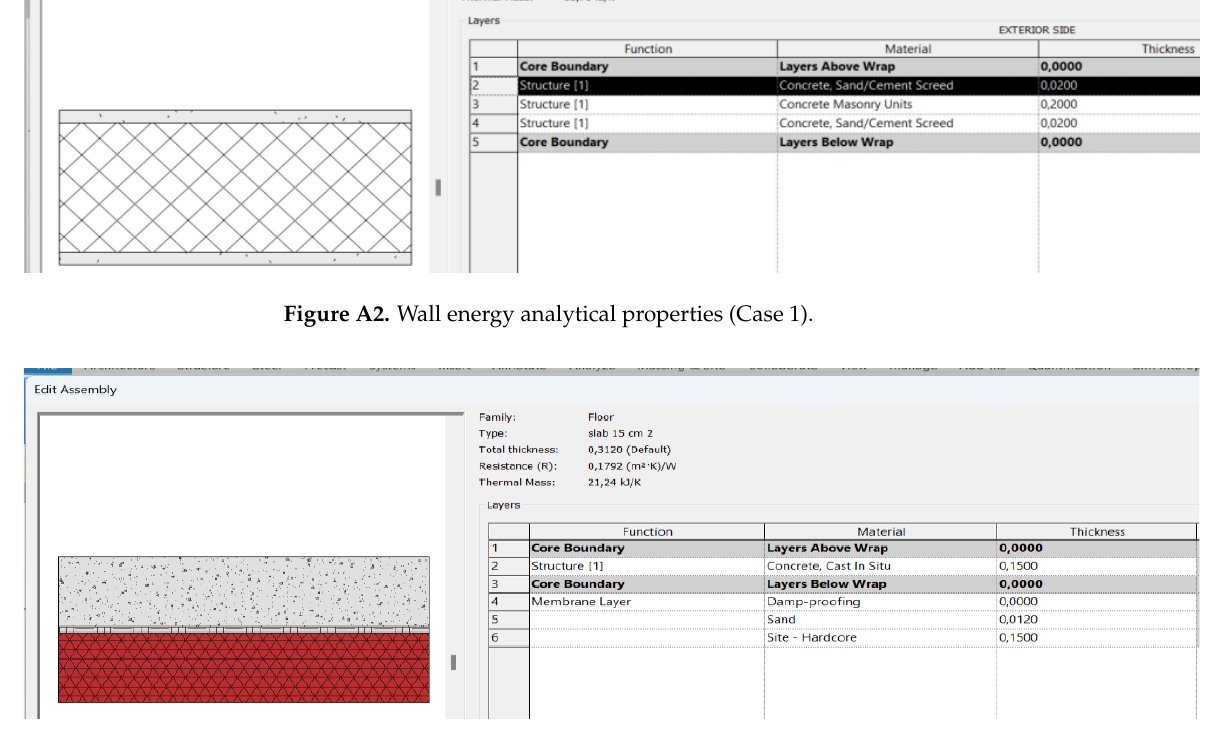
Figure A3. Slab energy analytical properties (Case 1).